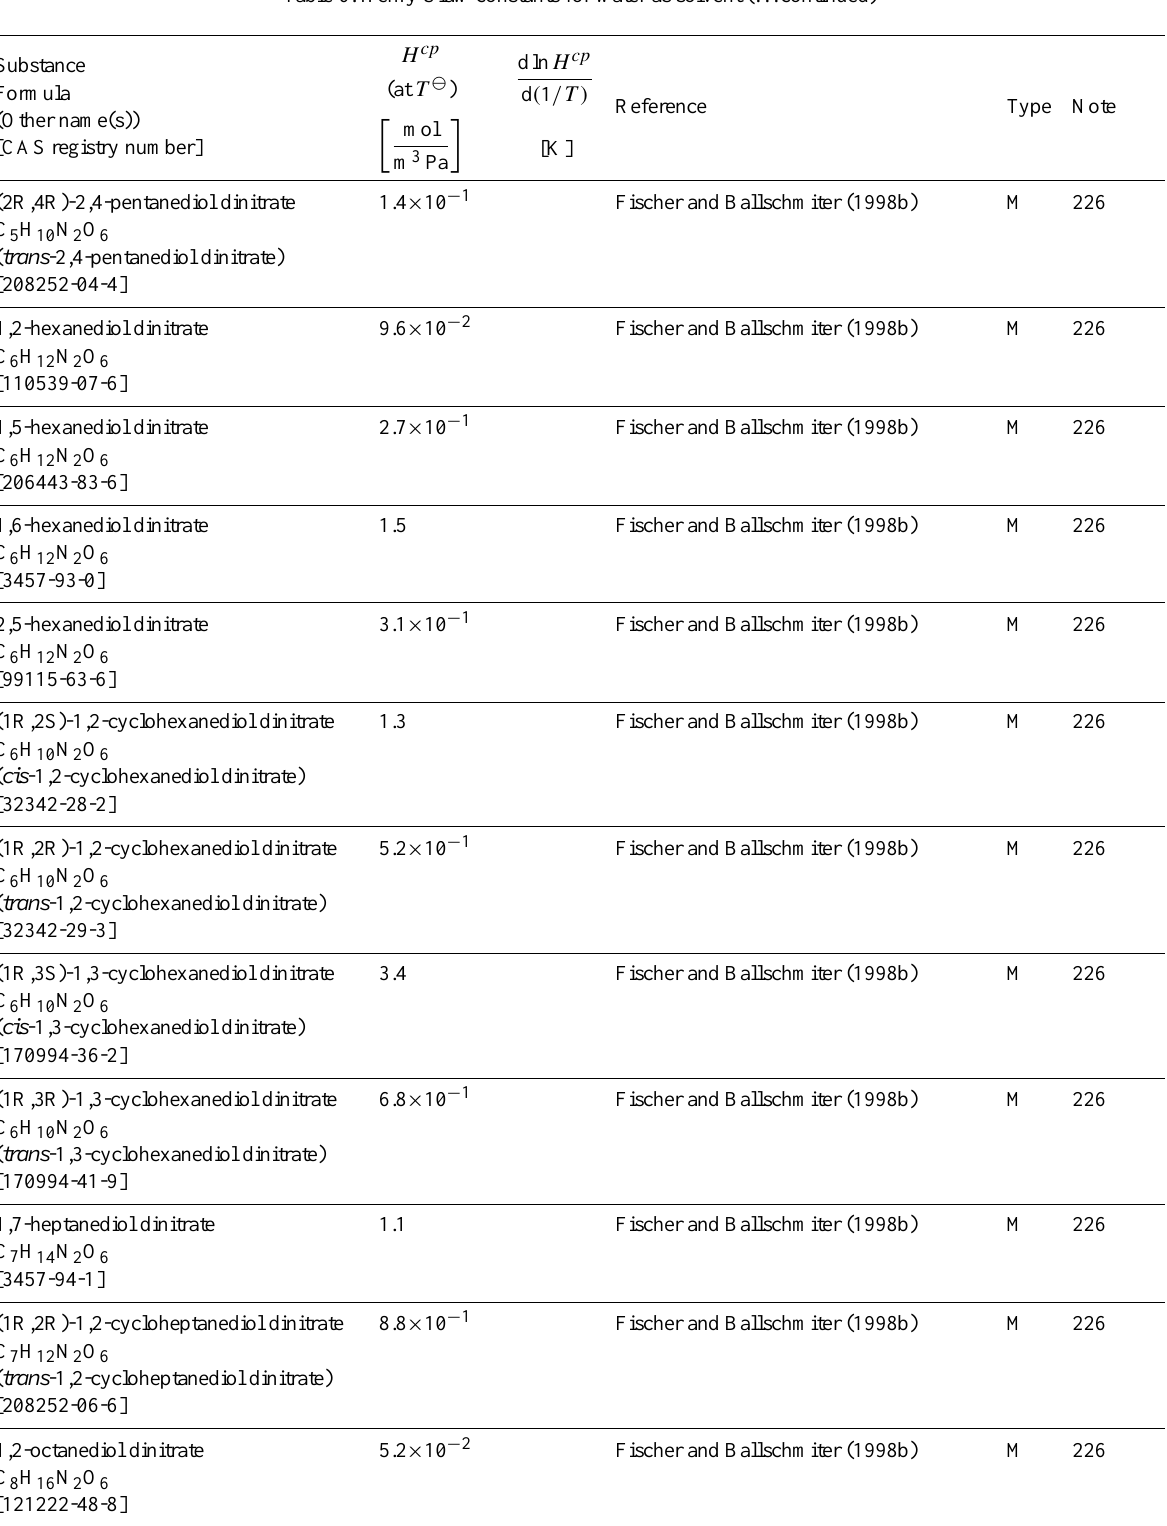
Table 6: Henry’s law constants for water as solvent